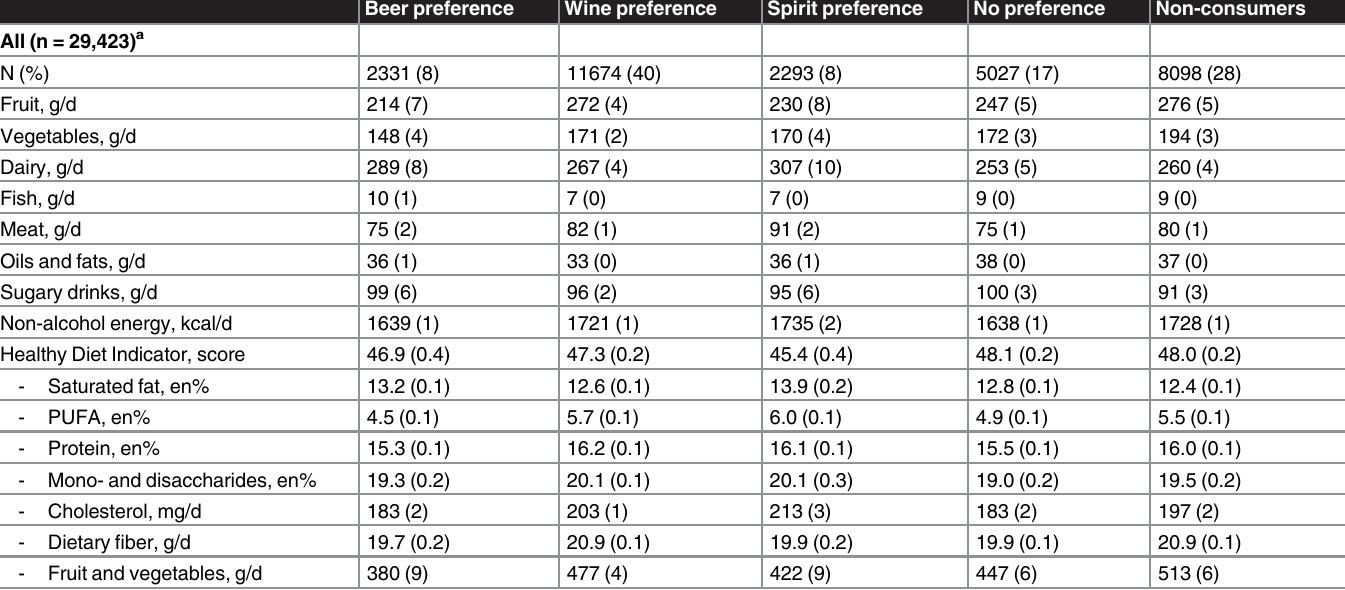
Table 3. Adjusted a food group and nutrient intakes (weighted mean and SE) across categories of alcoholic beverage preference of all cohorts combined. Beer preference Wine